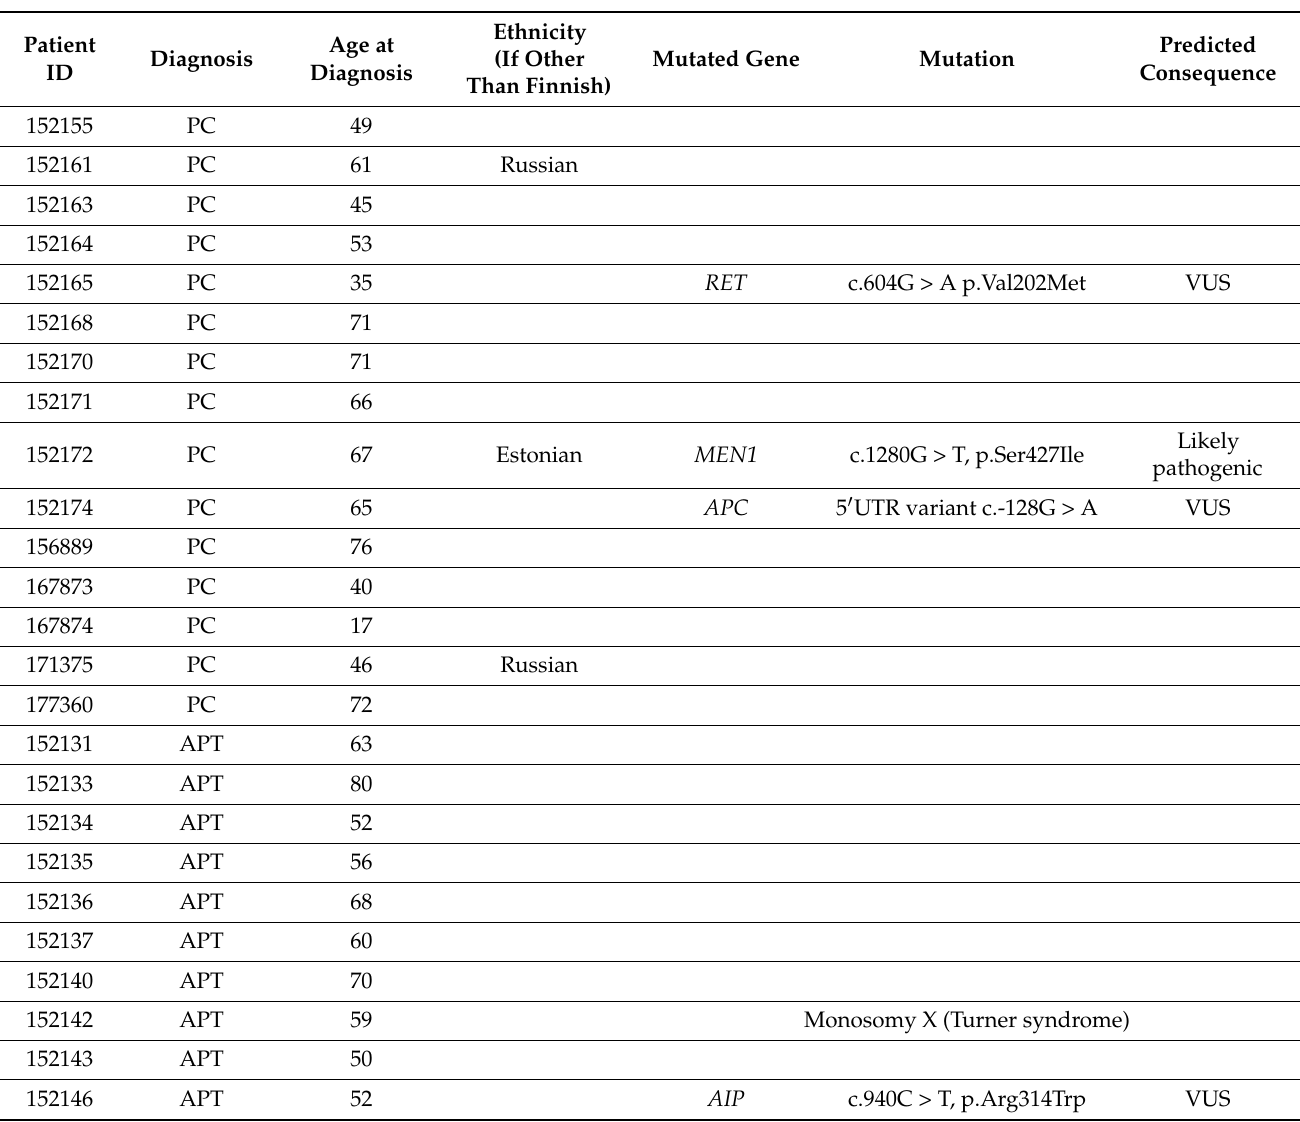
Table 2. Results of the customized Blueprint Genetics (BpG) hyperparathyroidism gene panel